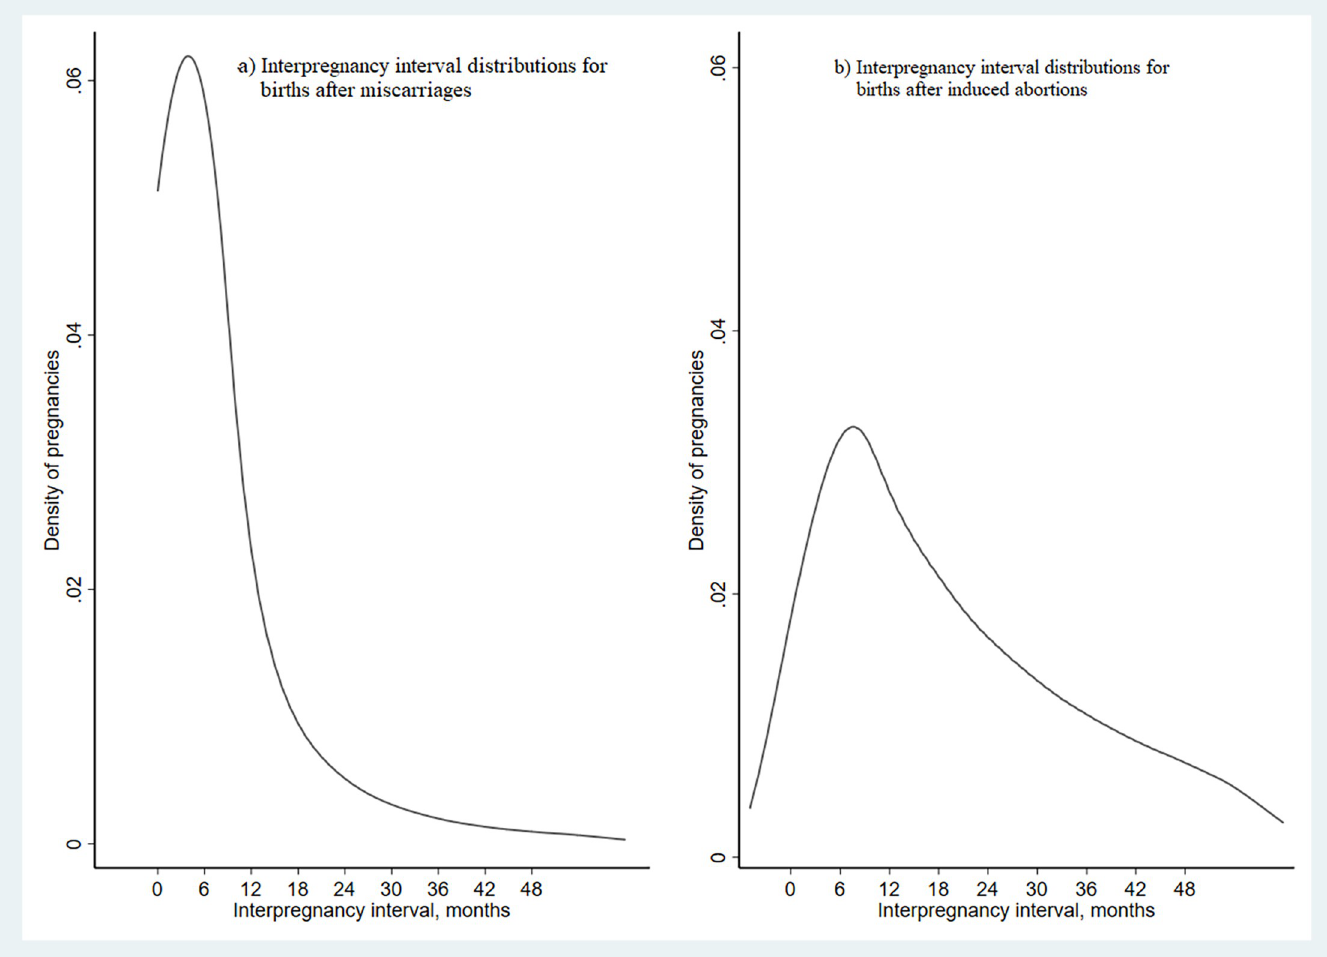
Fig 2. Kernel density distributions of interpregnancy interval after miscarriages and induced abortions for births between 2008 and 2016 in Norway.